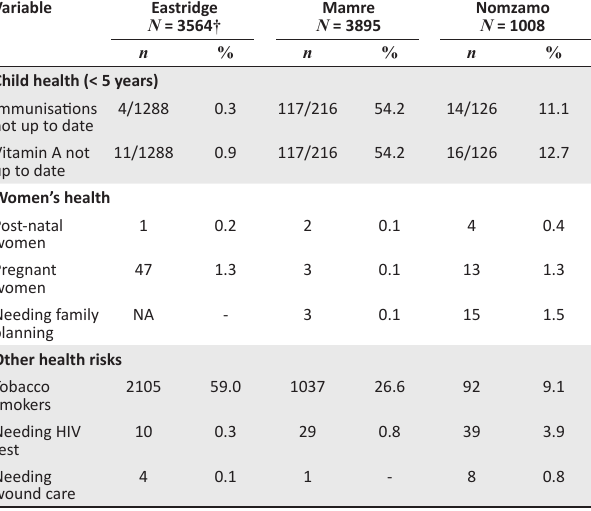
TABLE 4: Proportion of population identified as having a health